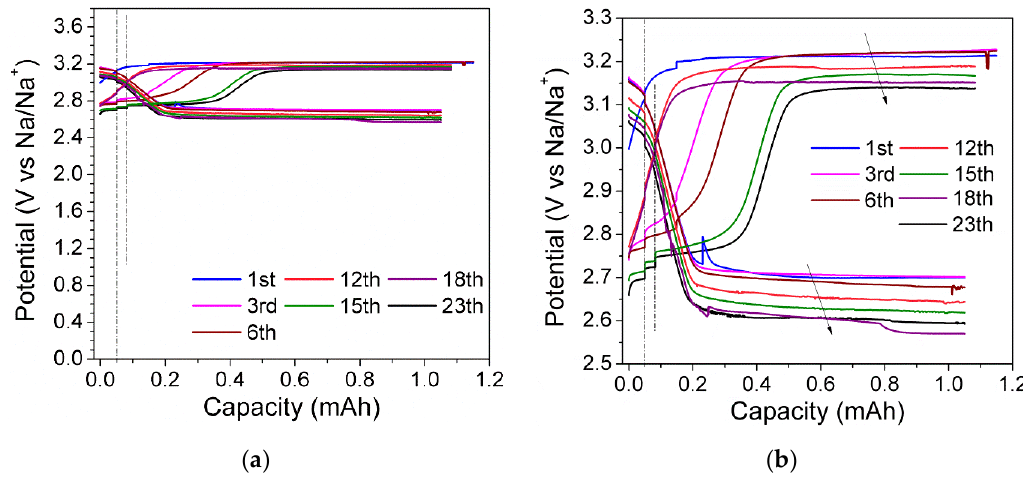
Figure 6. ( a ) Galvanostatic charge/discharge curves of a Na-Cs ‖ NaI flow cell with the cycle number indicated, and ( b ) zoom-in view of (a). The positive electrode is graphite felt GFD5.0 and catholyte is 0.068 M NaI aqueous solution, whereas the anode is made up of a Na 37 Cs 63 slurry. The discharge was under 0.05 mA current for 1 h as the activation step and then 0.1 mA current up to 1.0 mAh capacity, whereas the charging cycle was started at 0.05 and 0.10 mA for 1 h each and then at 0.15 mA until reaching 1.0 mAh for the first 10 cycles. In the subsequent cycles the 0.10 mA step was set to 20 min while the other steps were kept the same in the charge segment. The test was run in a dark box.